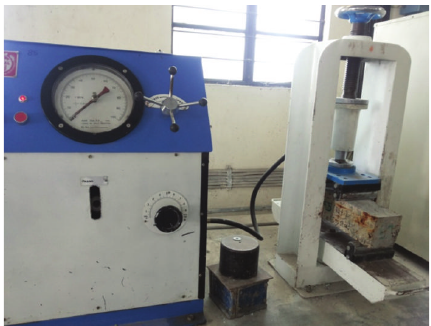
Figure 4: Snapshot of flexural test setup.